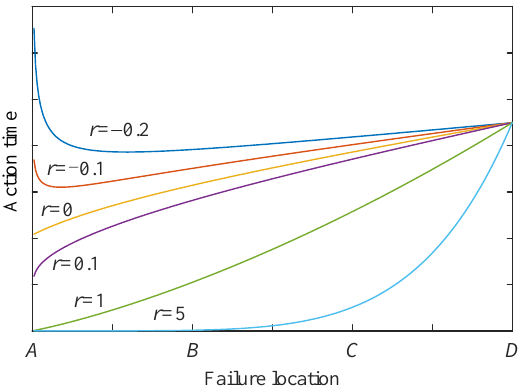
Figure 7. Influence of different impedance correction coefficients on the action time curve.